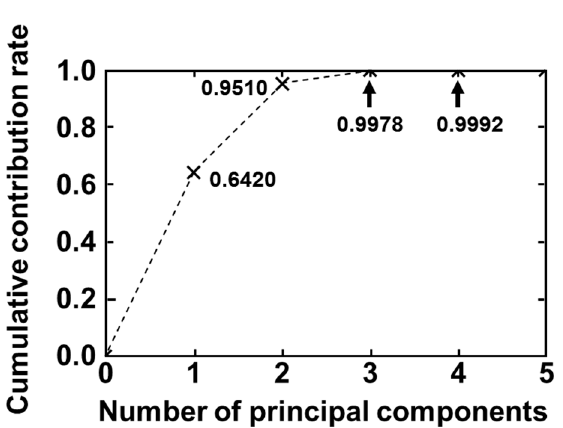
Figure 3. Cumulative rate of contribution to the number of dimension reductions (Gaussian error σ = 0%).